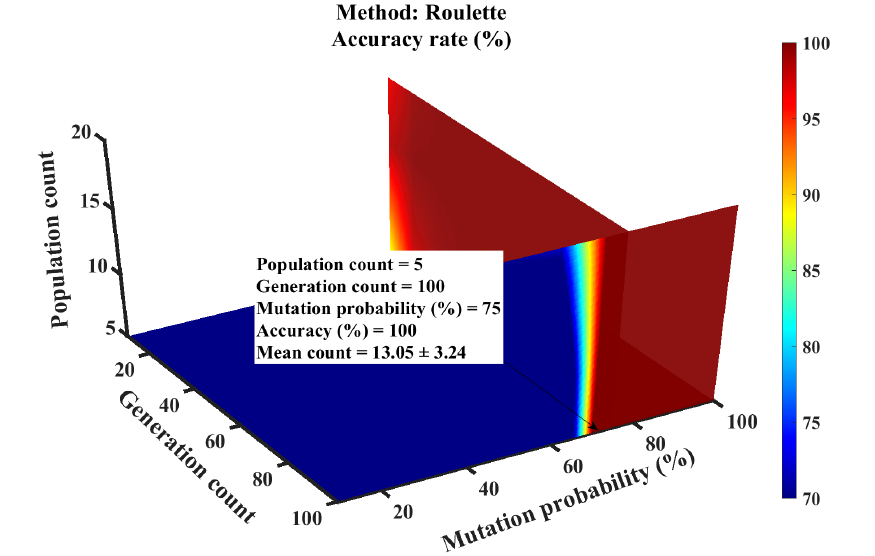
Figure 8. Single MoOx layer optimization using GA with roulette selection: accuracy (%) distribution data sliced at population size of 5, generation count of 100, and mutation probability of